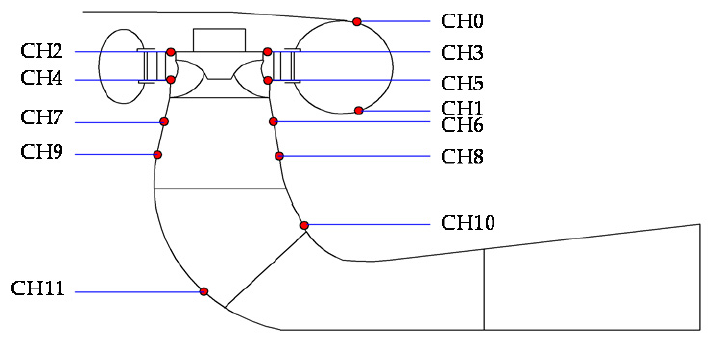
Figure 7. Locations of pressure-monitoring points. The fluctuation peak ∆ H/H was calculated by processing the pressure signal at the confidence level of 97%, and its definition is